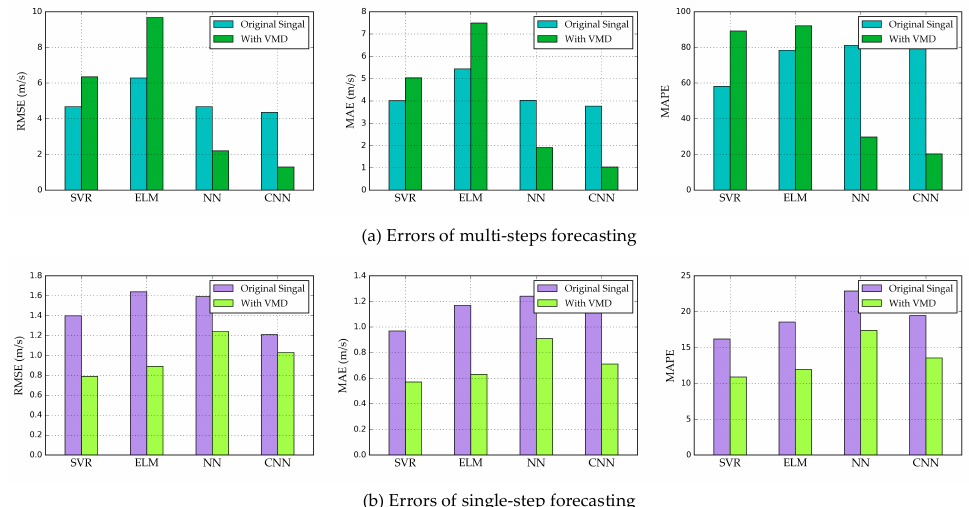
Figure 6. Evaluating indicators of forecasting models: ( a ) multi-step forecasting, ( b ) single-step forecasting. RMSE: root mean squared error; MAE: mean absolute error; MAPE: mean absolute percentage error.